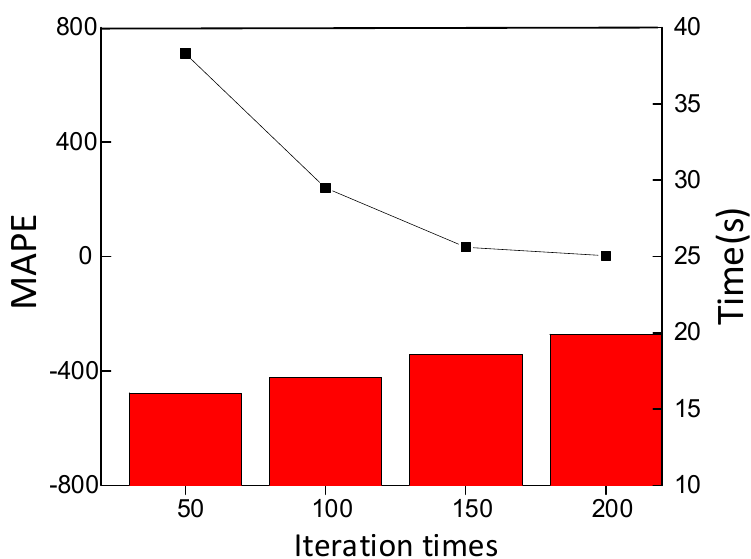
Figure 7. The loss-iteration times.